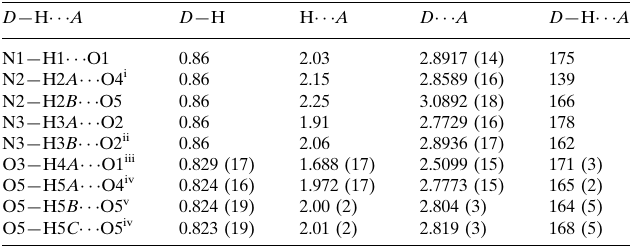
Hydrogen-bond geometry (A˚ , (cid:3)